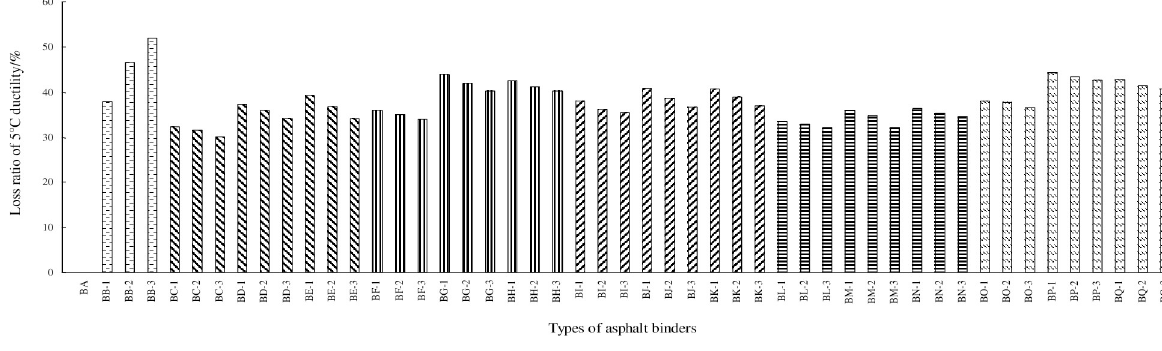
Fig 4. Loss ratios of the 5˚C ductility.